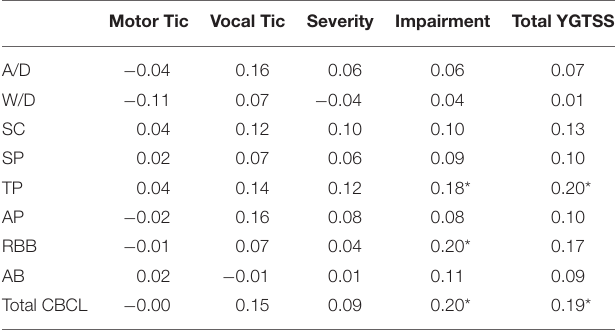
TABLE 2 | The Pearson correlation of YGTSS and the CBCL in Tourette syndrome ( n = 124).